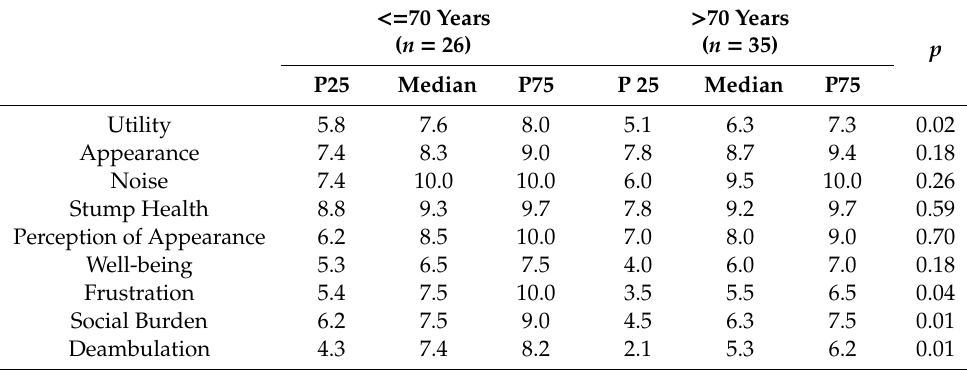
Table 4. PEQ domain levels in relation to patient